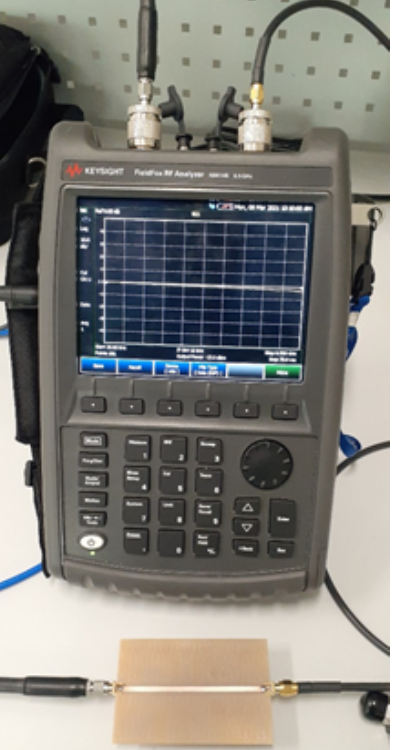
Figure 8. Measurement Setup for Transmission Loss.